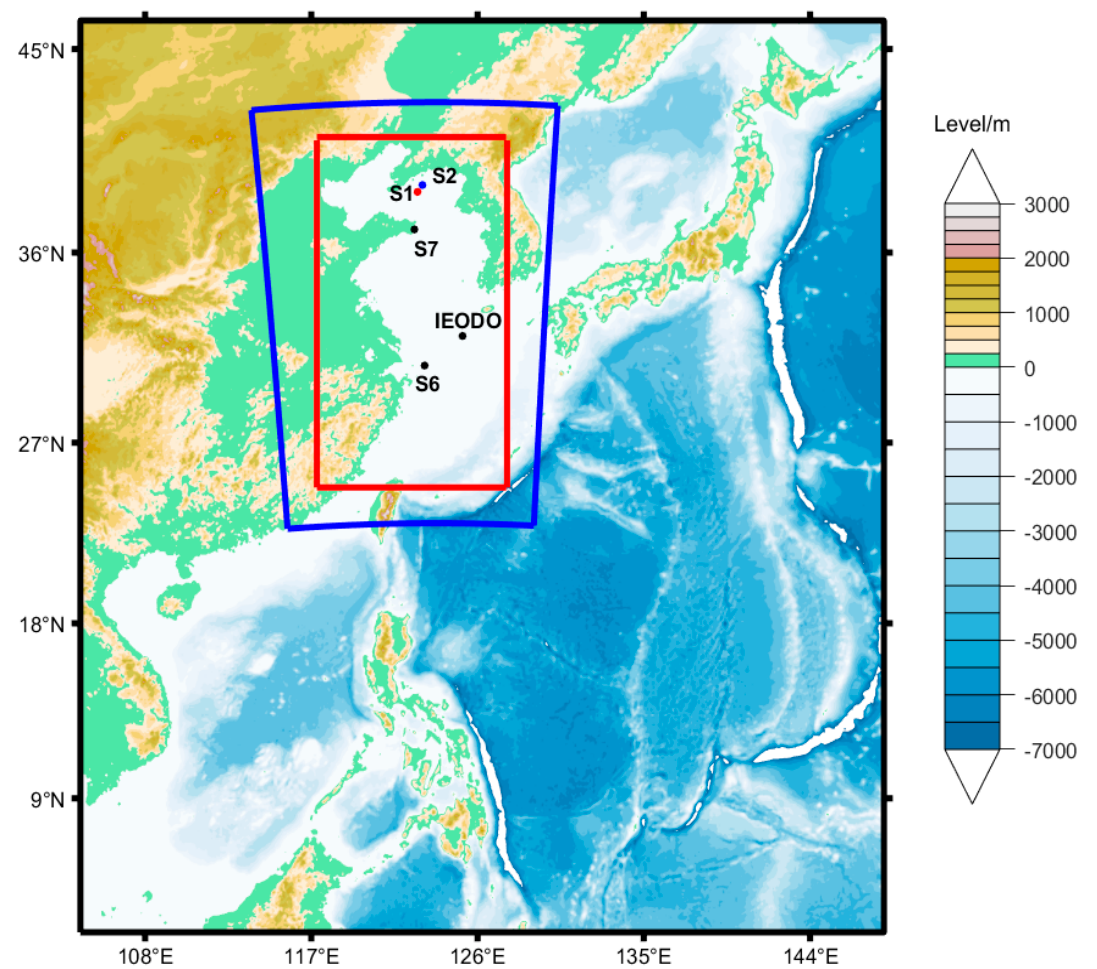
Figure 1. Topography of model areas: The outermost one indicates a domain for WAM simulation over the northwest Pacific region with a special resolution of 0.1° (NW-Pacific WAM), red square indicates domain of fine-resolution (0.05°) WAM simulation and CCLM-WAM coupling, nested within NW-Pacific WAM, the blue square is the domain of CCLM simulations. Black points indicate the locations of wind and wave observations, red points represent the locations of wind observations only, and blue points represent the locations of wave observations only.